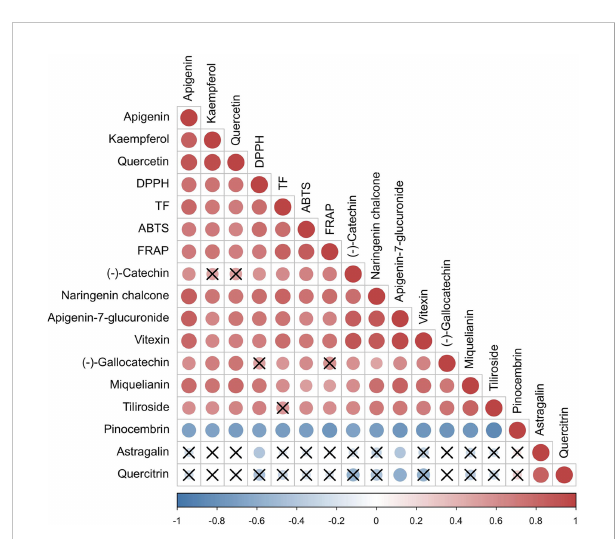
FIGURE 6 Correlation among antioxidant activities and concentration of fl avonoid markers. The red colour indicates the positive correlation, the blue colour indicates the negative correlation. The “ × ” sign indicates that the corresponding correlation is not statistically signi fi